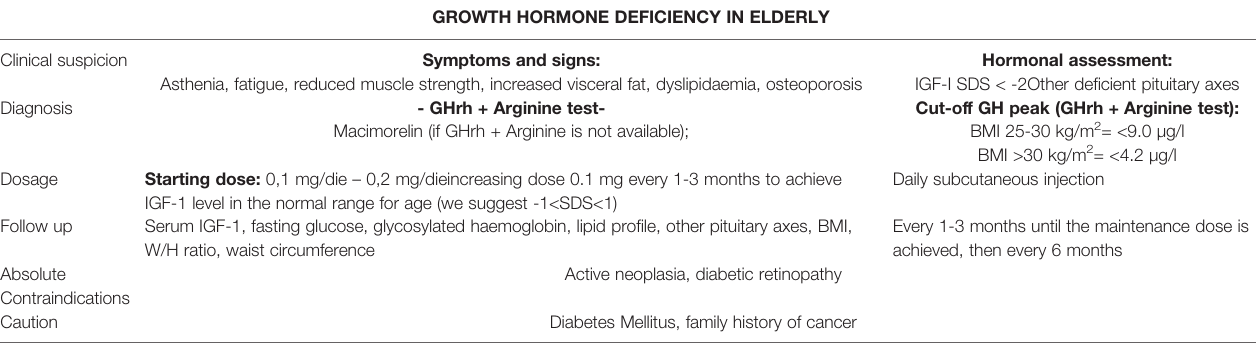
TABLE 1 | A brief report about clinical suspicion, diagnosis, GH replacement therapy (GHrt) dose and titrating and follow up in elderly patients with GHD (EGHD). GROWTH HORMONE DEFICIENCY IN